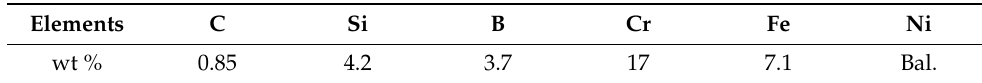
Table 2. Chemical compositions of Ni60AA.